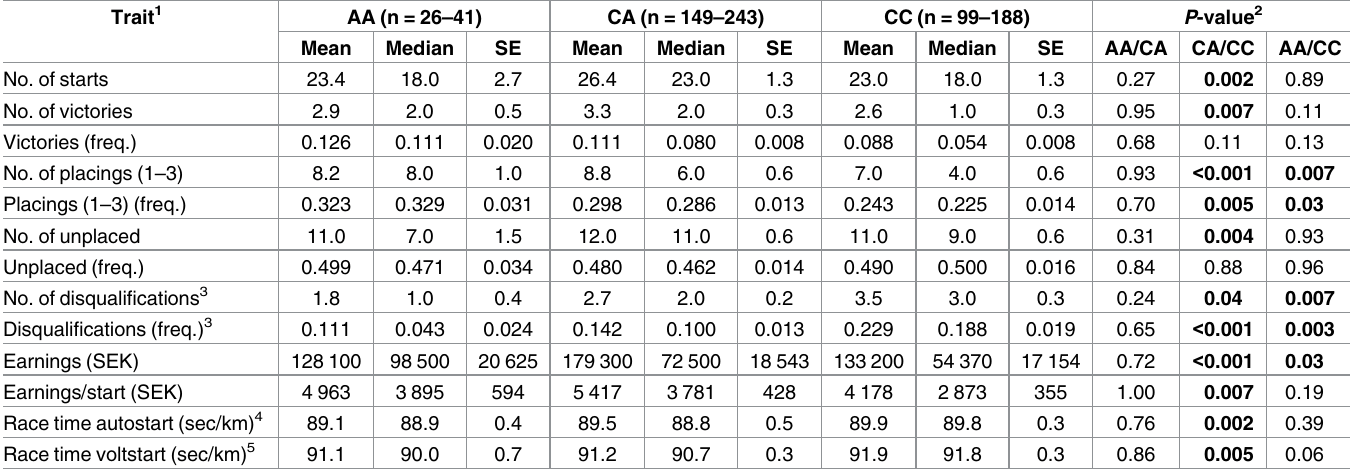
Table 3. Mean and median racing performance results for Coldblooded trotters at 3 to 6 years of age according to DMRT3 genotype (n = 472). Trait